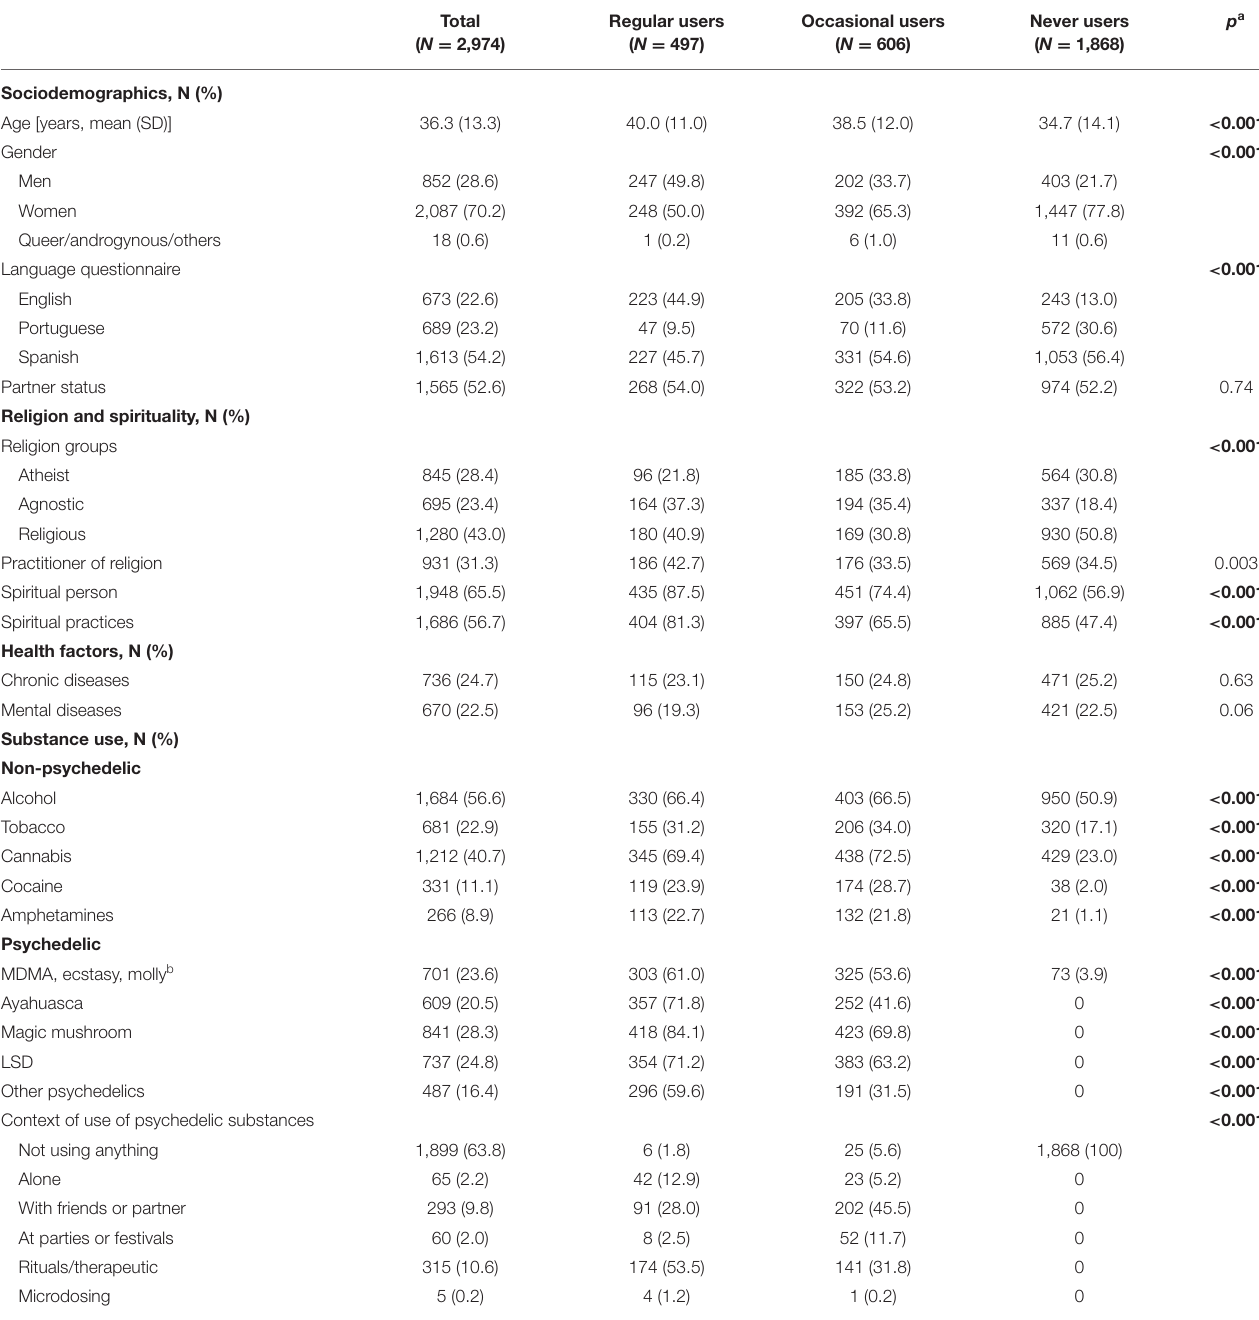
TABLE 1 | Sample characteristics of the total sample, and regular vs. occasional vs. never users of psychedelic substances in the